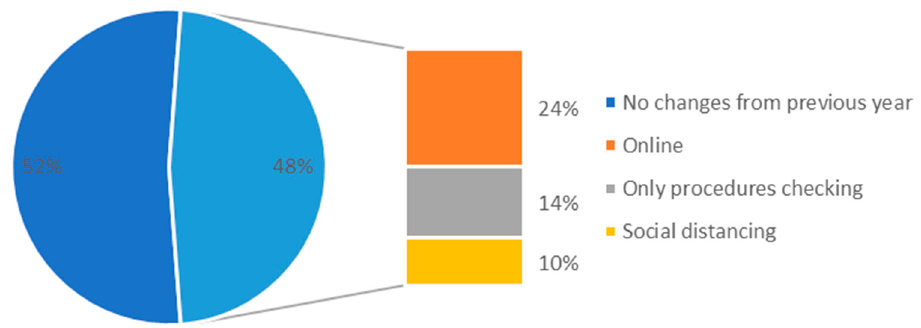
Figure 3. Perceptions regarding the main causes of FSC CoC audit changes during the COVID-19 pandemic.